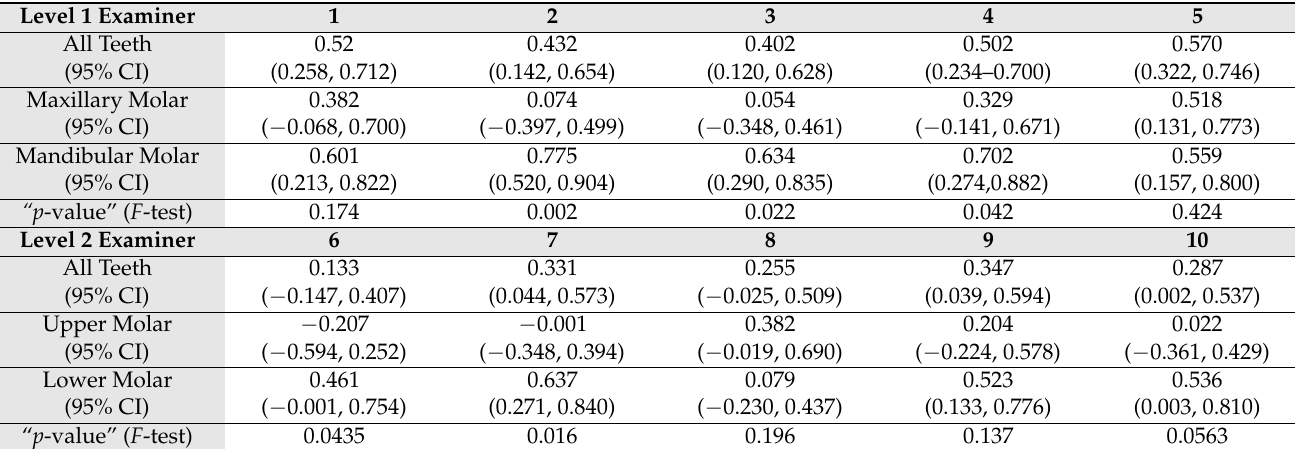
Table 1. Intraclass correlation coefficient (ICC) for vertical depth of furcation involvement measured by conventional modality against